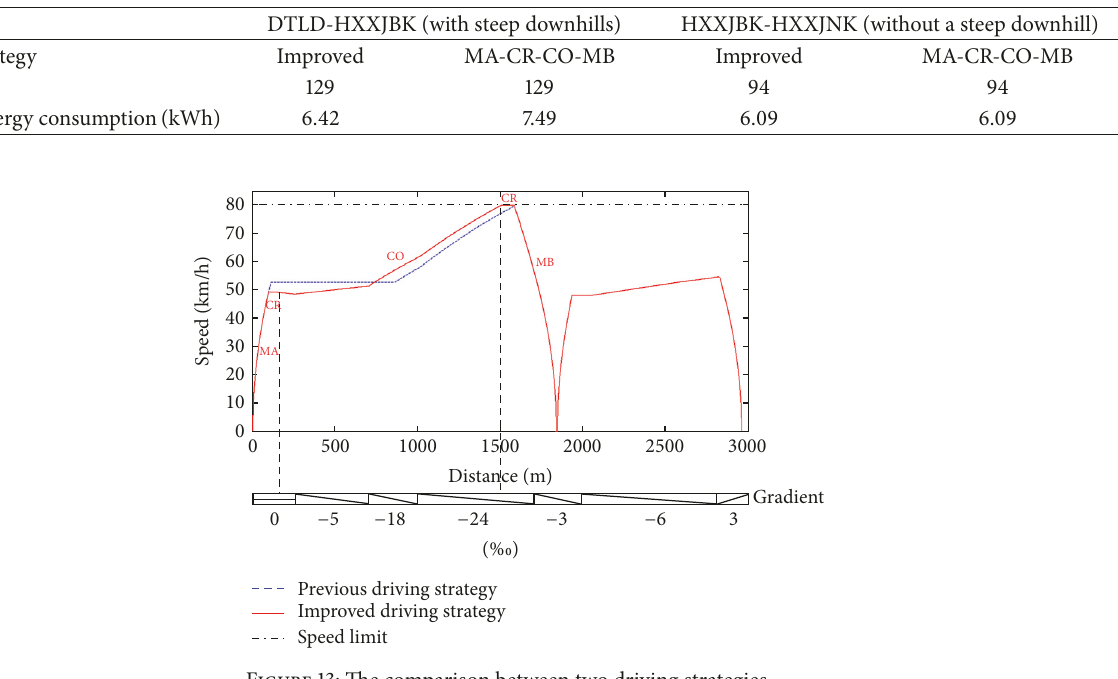
Table 3: Energy performance of the improved train control model.